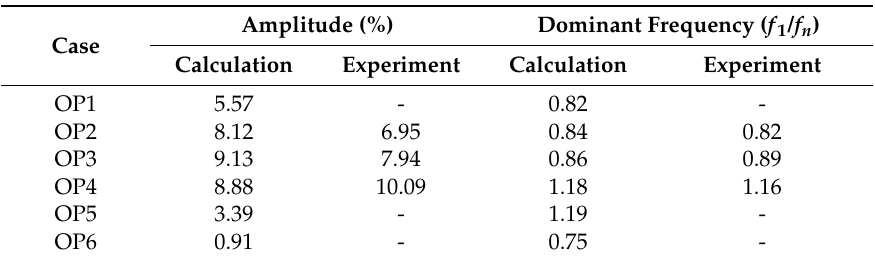
Table 7. Amplitude and dominant frequency of pressure fluctuations at DT2.